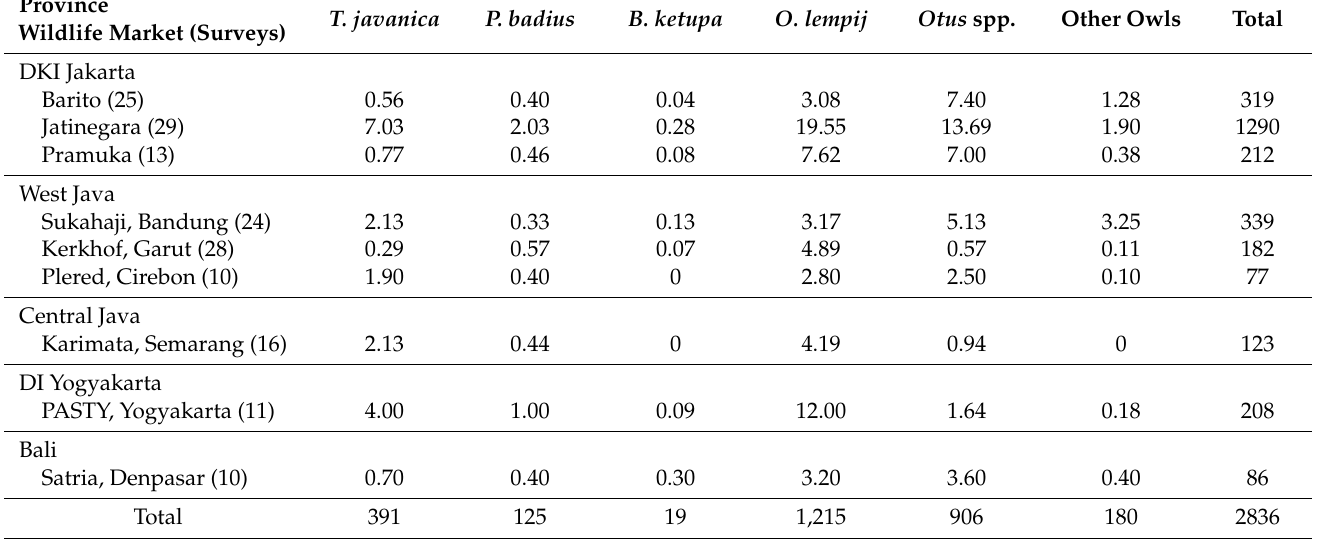
Table 2. Trade in owls on Java and Bali (2012–2020) showing mean numbers per survey for the most traded species and totals for each wildlife market and species. Species: Australasian barn owl Tyto